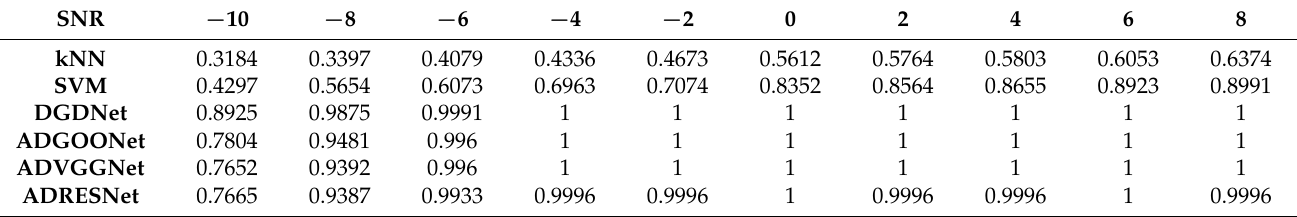
Table 2. Detailed indicators of four methods.